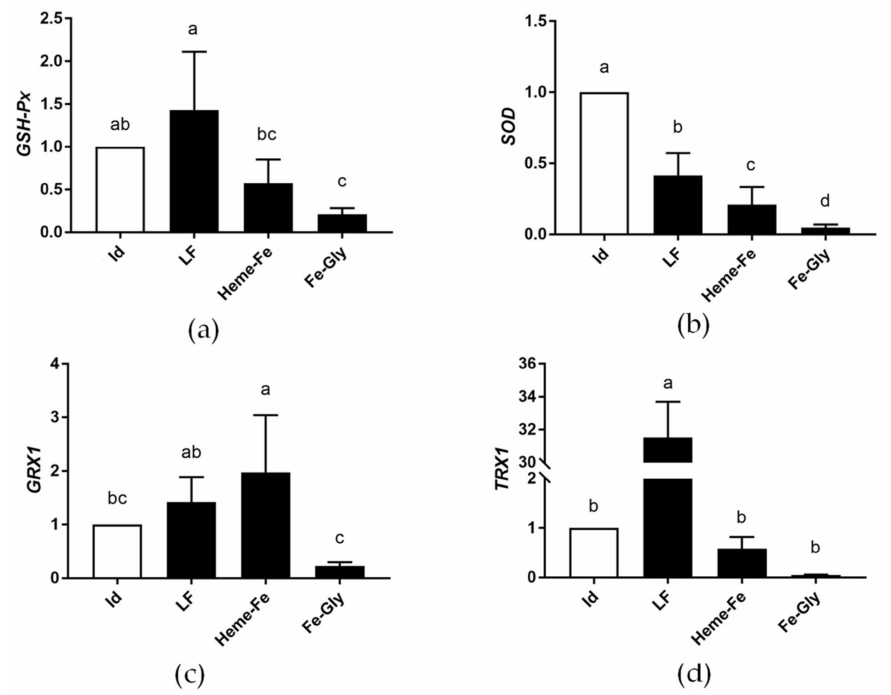
Figure 2. Effects of different iron sources on GSH-Px ( a ), SOD ( b ), GRX1 ( c ), and TRX1 ( d ) gene expression in neonate piglet liver. Id: iron deficiency group; LF: lactoferrin group; Heme-Fe: heme iron group; Fe-Gly: Fe glycinate group. Values in columns with different small letters indicate significant difference ( p <